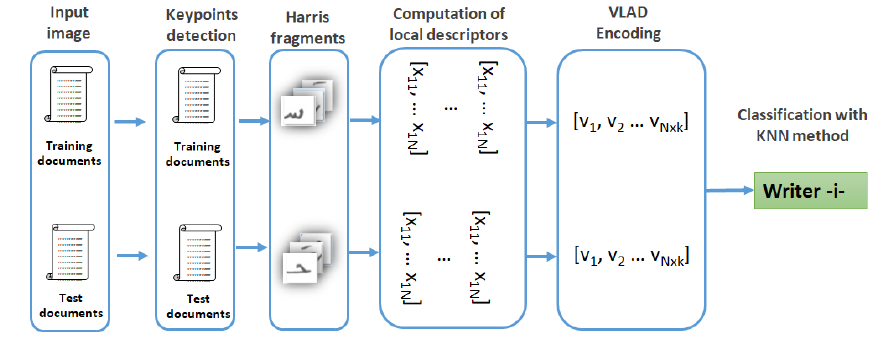
Fig. 1. The main steps of our